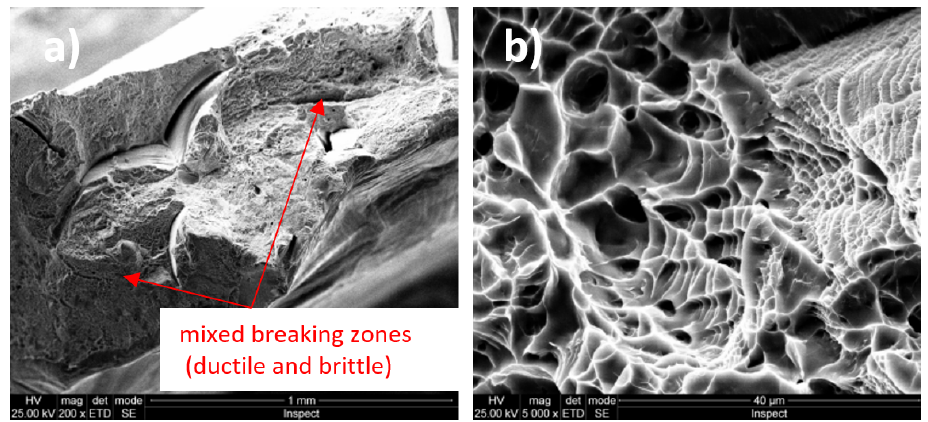
Figure 4. Fracture surfaces (fractography) images of Ti20Mo7Zr10Ta alloy: ( a ) 200×; ( b ) 5000×.